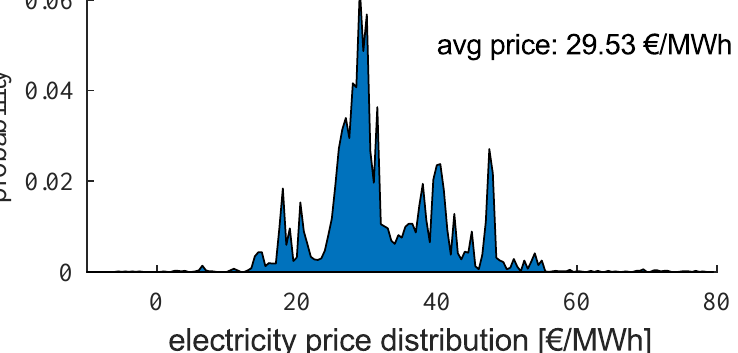
Figure 10. Simulated price distributions for Germany in 2014 in the EULR approach with fixed exchange schedules as used in figure